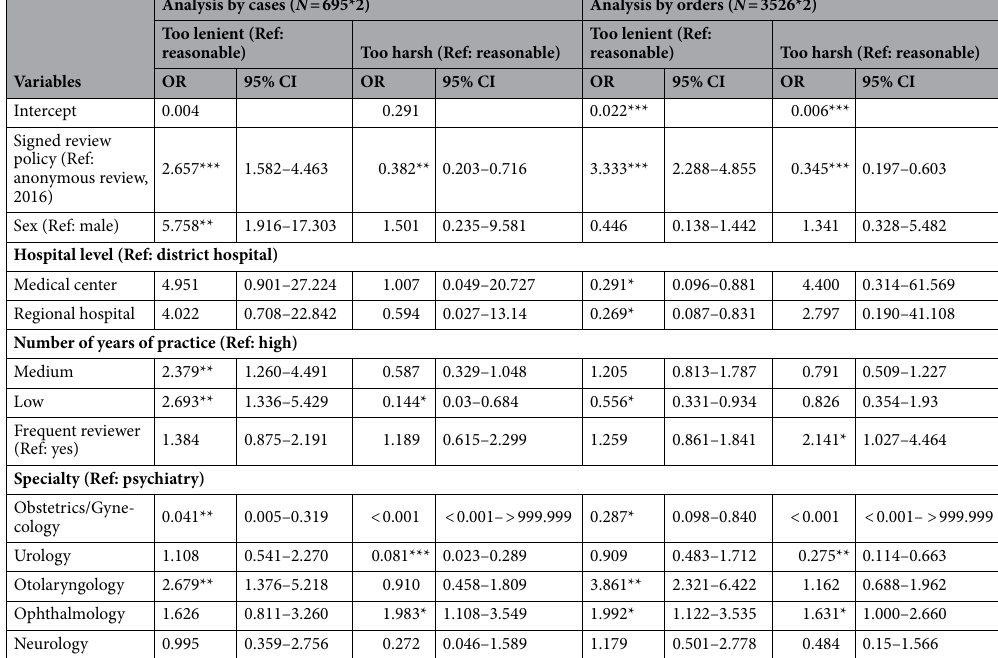
Table 5. Multinomial logistic regression of GEE models examining the effect of the signed review policy on the appropriateness of the review decision under the Taiwanese National Health Insurance scheme. * P < 0.05, ** P < 0.01, *** P <